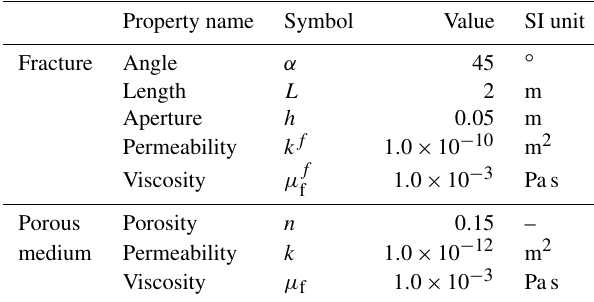
Table 2. Material properties the example of flow in a fractured porous